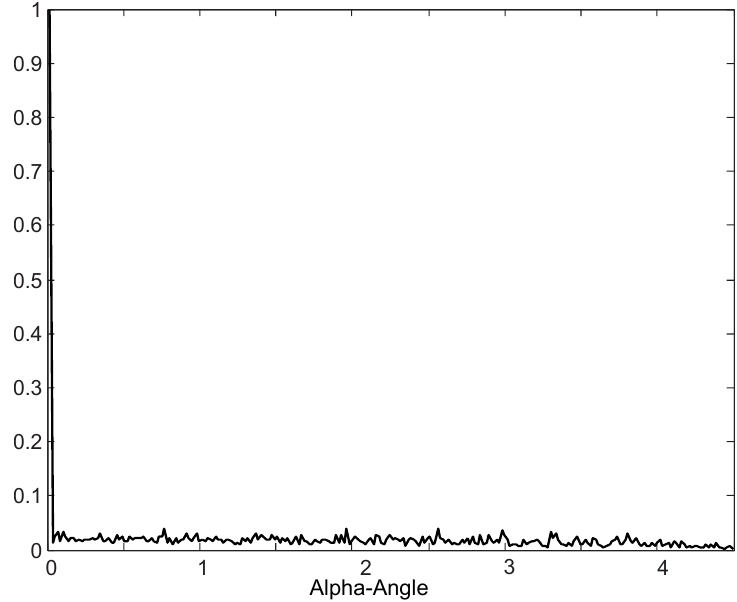
Figure 1. Alpha-Angle profile calculated for a Gaussian noise with zero mean and unit